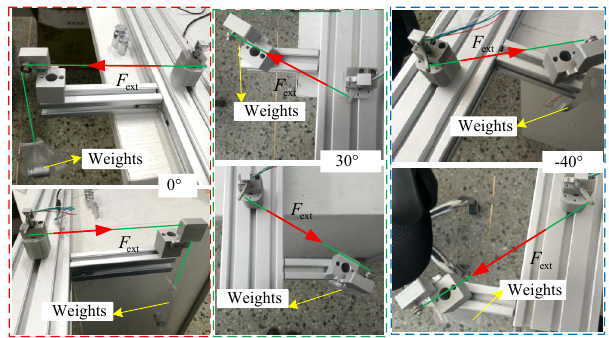
Figure 19. External force estimation experimental system.